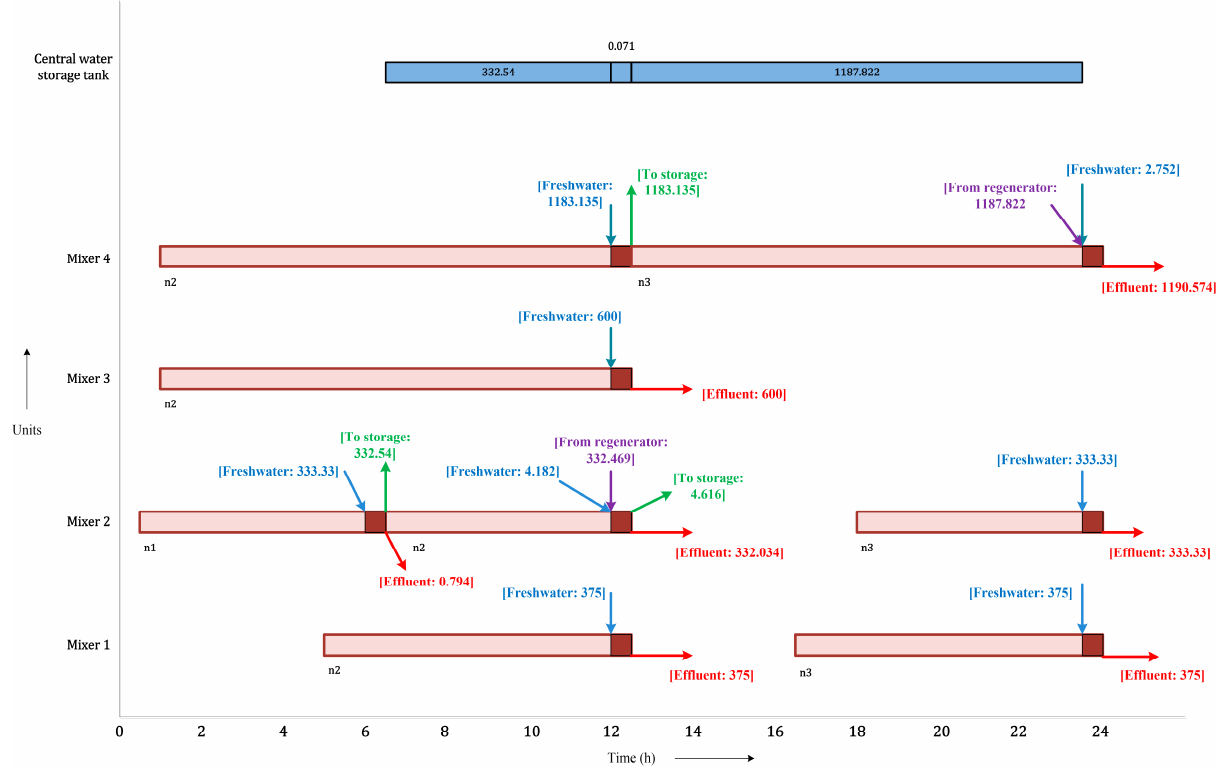
Figure 15. Gantt chart for the simultaneous approach for case study 4 with water storage tank and regenerator.